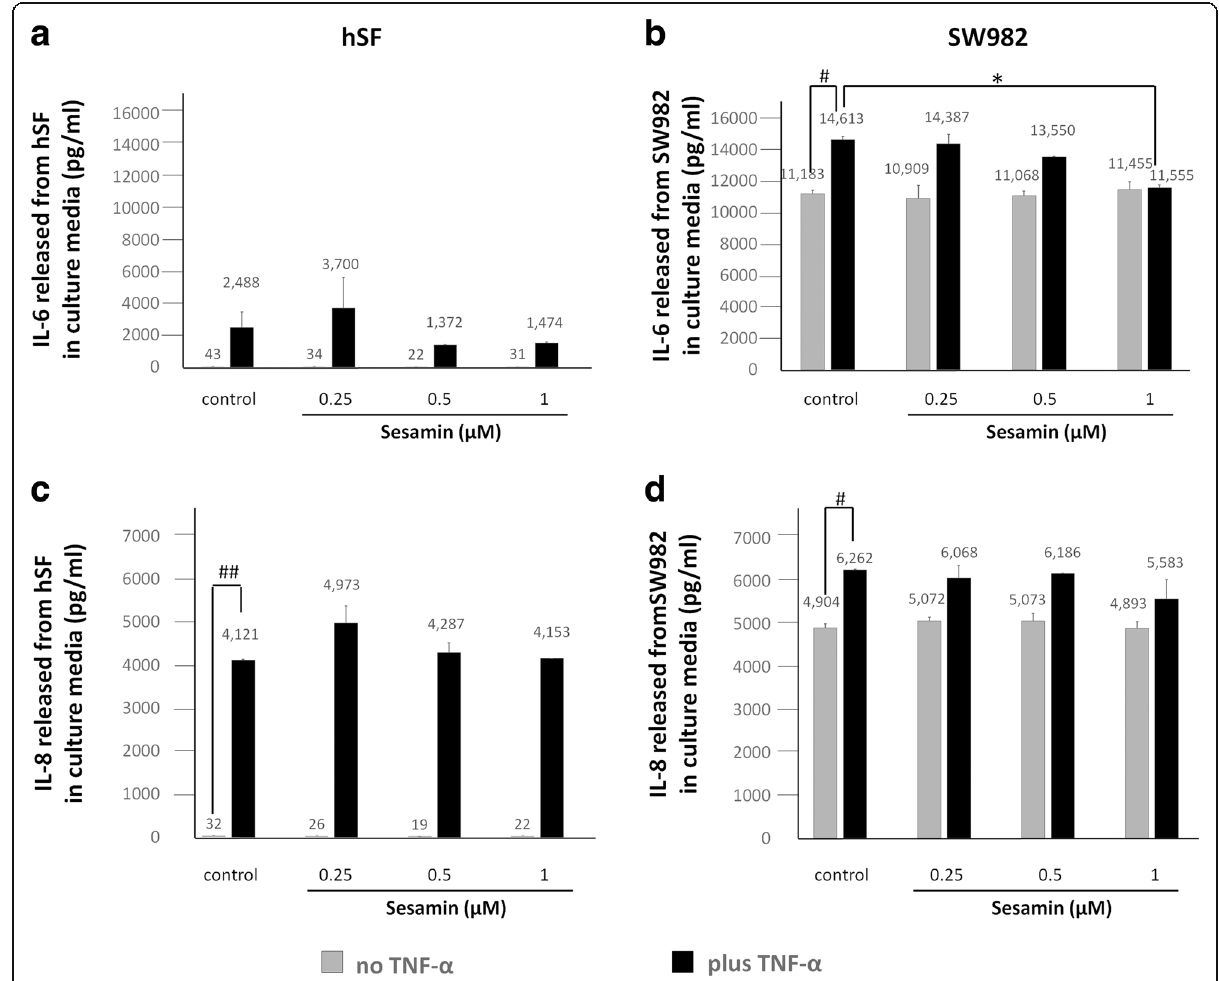
Fig. 3 Levels of IL-6 and IL-8 released in the culture medium of hSF and SW982 cells. Both cell types were treated and assayed as described above. The levels of IL-6 and IL-8 released in the cultured medium were analysed by Luminex assays. a, b Levels of IL-6 production from hSF and SW982 cells, respectively. c, d Amounts of IL-8 released from hSF and SW982 cells, respectively. Values are expressed as the mean±SEM ( n =3). #, * = p <0.05; ##, ** = p <0.01 versus normal control (#) or TNF- α treatment (*) by one-way